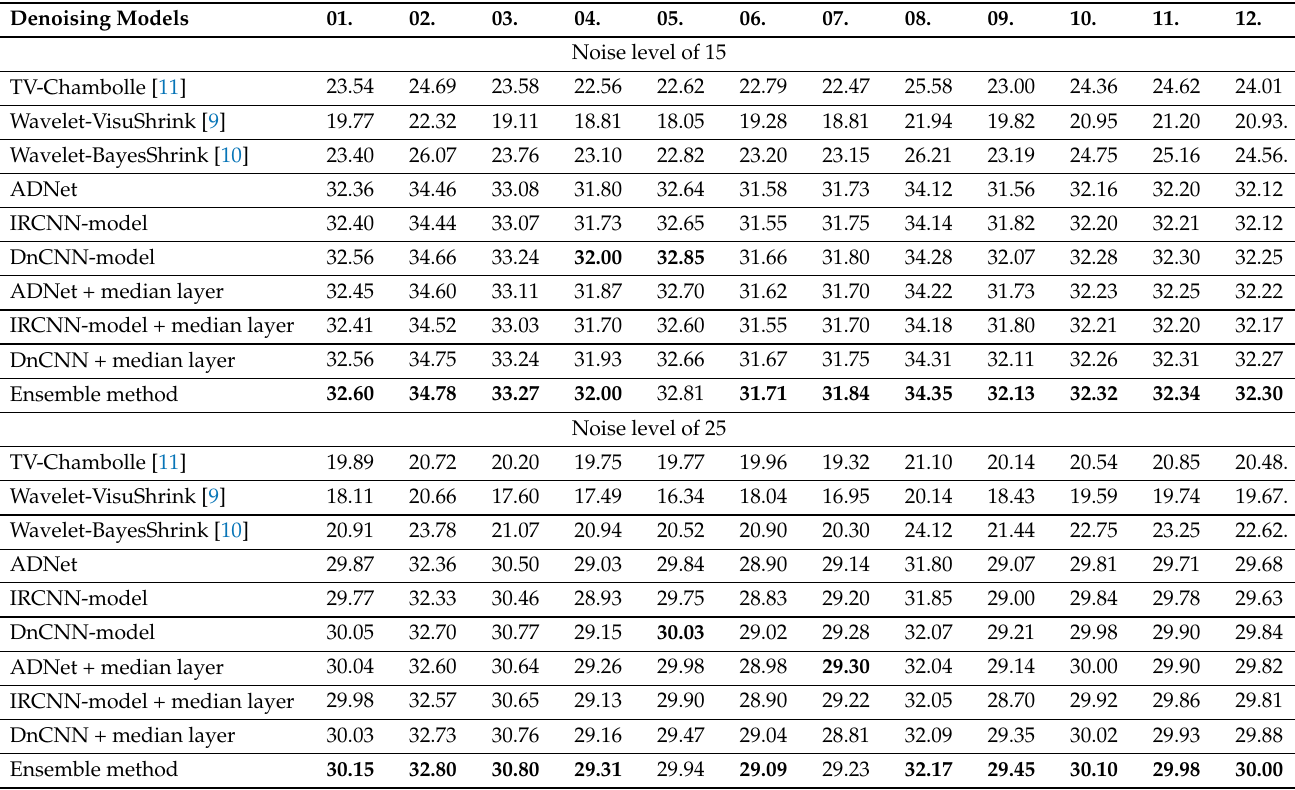
Table 2. Peak-signal-to-noise ratio (PSNR) values of images predicted by the image denoising models for different noise levels on Set12 image dataset. Denoising